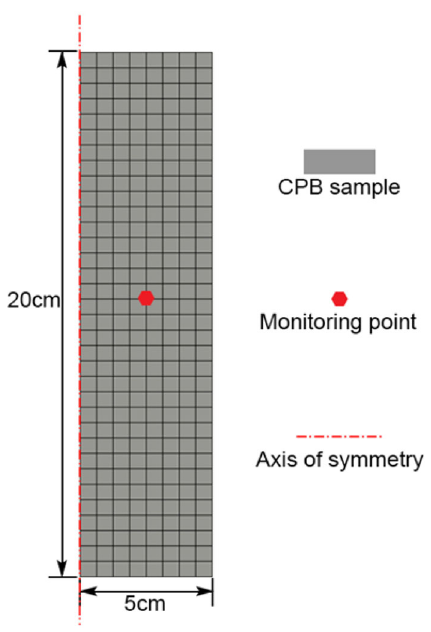
Fig. 12 Mesh and geometry of simulated CPB sample in Case Study 3.